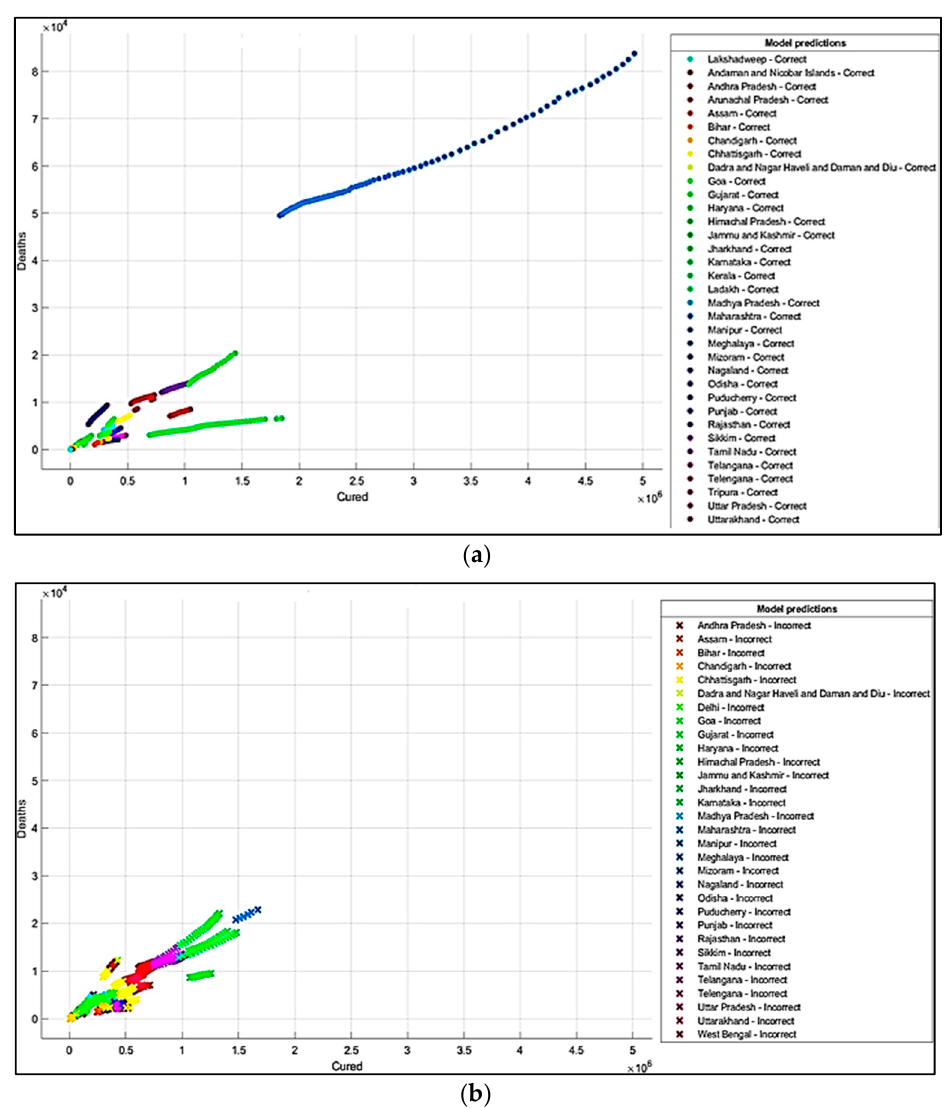
Figure 4. ( a ) Correct Predictions by Decision Tree ‘Cured’ vs. ‘Deaths’. ( b ) Incorrect Prediction by Decision Tree ‘Cured’ vs. ‘Death’.